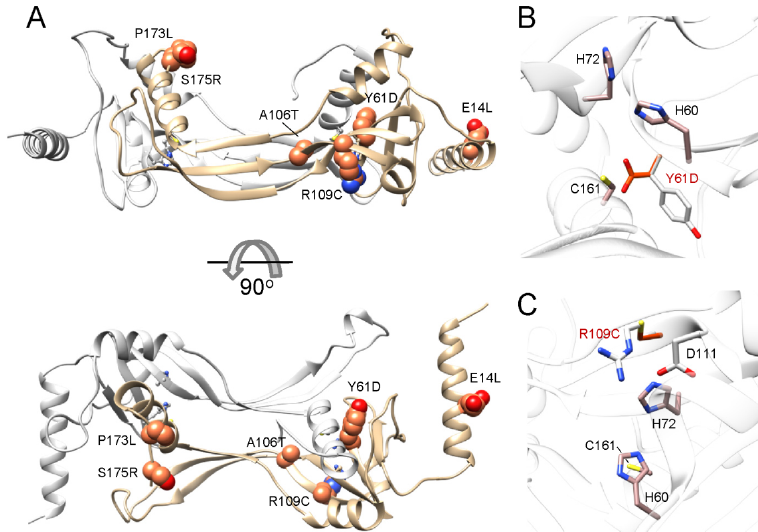
Figure 5. Location of pathogenic mutations within the LRAT structure. ( A ) Substituted residues associated with retinal degenerative diseases (shown as spheres and colored in orange) are predominantly clustered within the catalytic domain with exception of L14E localized in the N -terminal helix; Panels ( B , C ) represent close-up views of residues Y61 and R109, respectively. Their proximity to the active site may indicate mutations affecting these amino acids might disrupt the active site geometry and thus disable the enzyme. Residues that substitute native amino acids are shown in red. Residues involved in the catalysis are colored in light